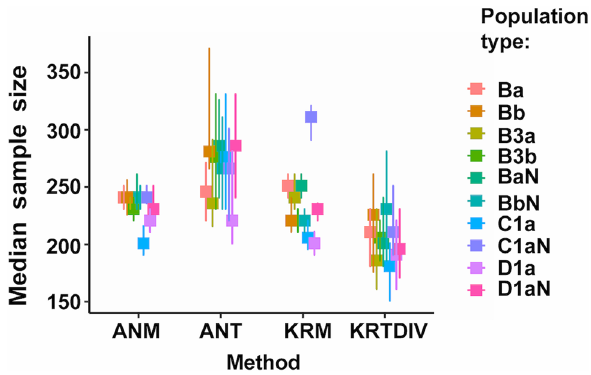
Figure 3. Simulation run_one relaxed: population group means: G1: 100; G2: 100-0.5; G3: 100-1; population variance: 5; relaxed = samples chosen regardless of whether they satisfied ANOVA assumptions. Medians of measured (ANM: ANOVA, KRM: Kruskal-Wallis) and Monte-Carlo predicted (ANT: ANOVA, KRTDIV: Kruskal-Wallis) sample sizes for 80% power. Error bars: 95% confidence intervals. For run settings, algorithms and Population type definitions, see Tables 1 and